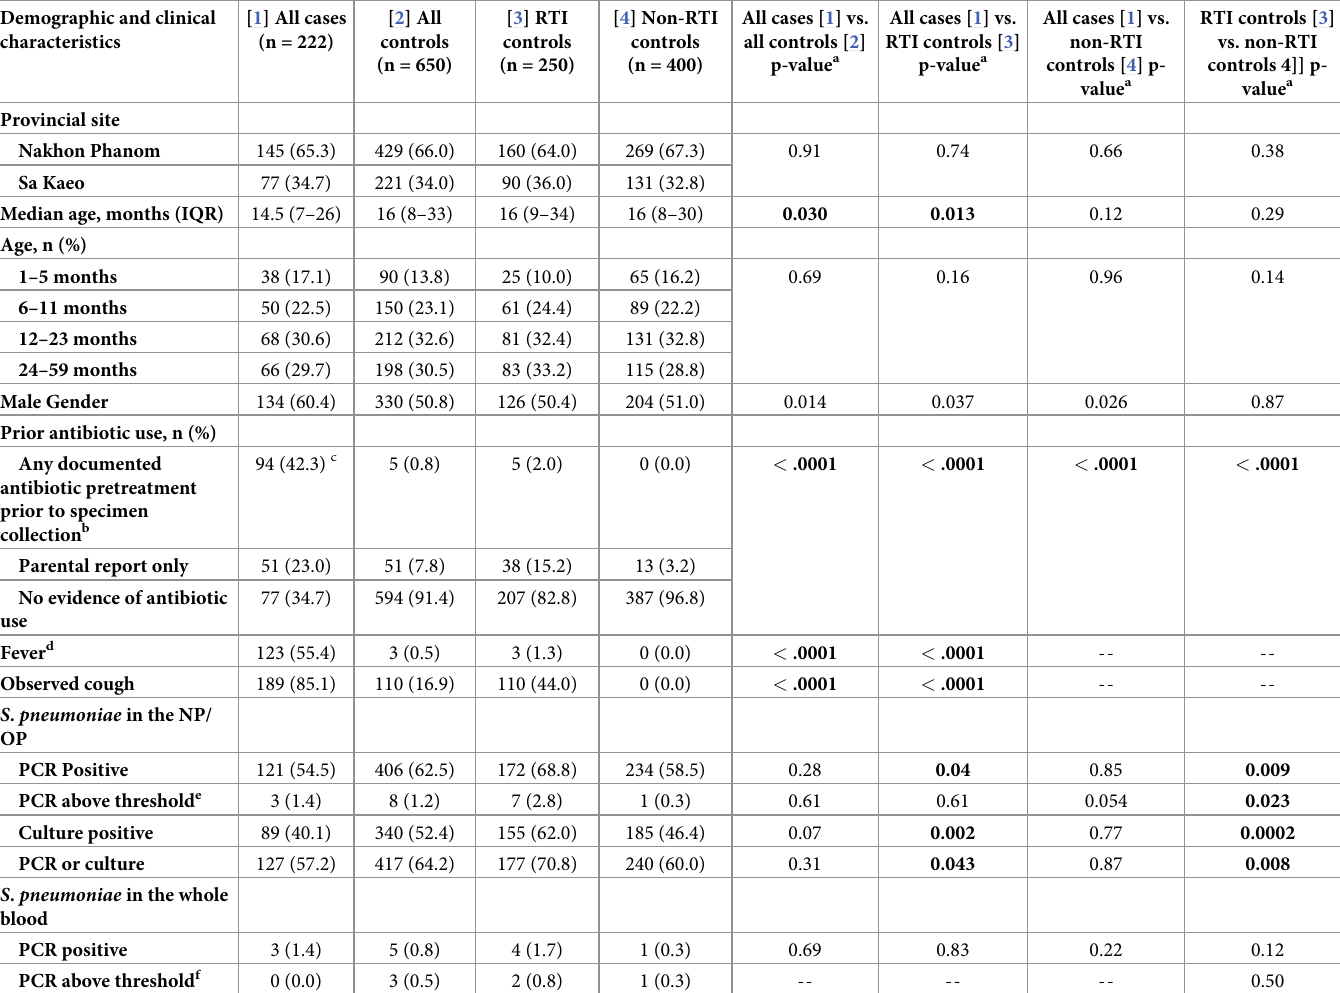
Table 1. Demographic and clinical characteristics by case and control group in rural Thailand. Demographic and clinical